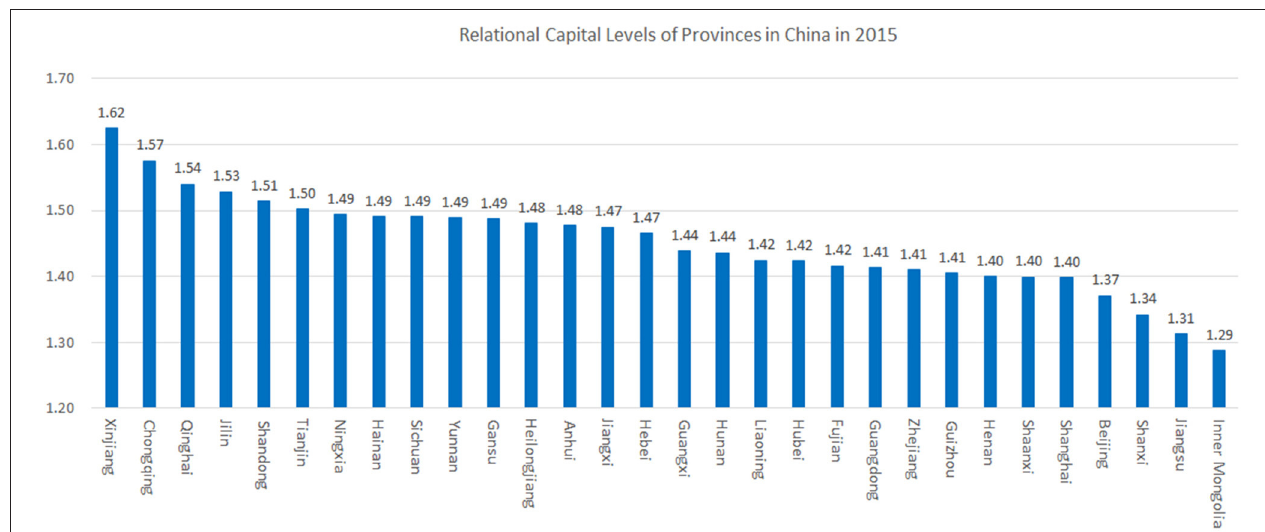
FIGURE 3 | Relational capital levels of provinces in China in